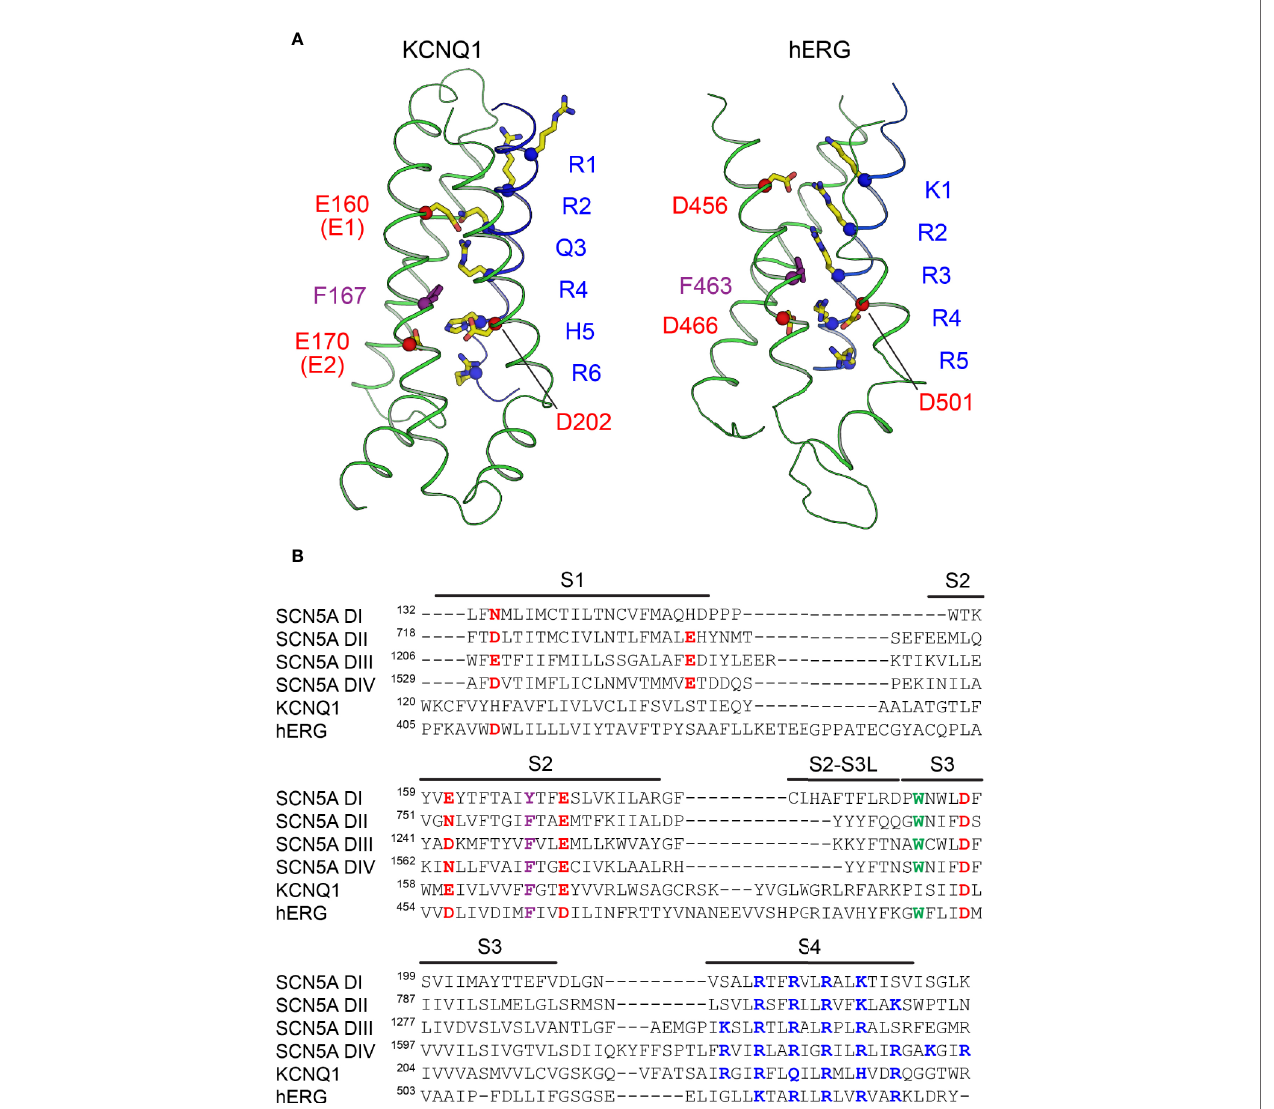
FIGURE 3 | The voltage sensors of KCNQ1, hERG, and SCN5A. (A) Structure of the VSD from human KCNQ1 (left) (PDB: 6UZZ) (Sun and Mackinnon, 2020) and hERG (right) (PDB: 5VA2) (Wang and Mackinnon, 2017) in putative activated conformations. Basic residues on S4 (labeled in blue), acidic residues on S2 and S3 (labeled in red), and the phenylalanine residue in the gating charge transfer center (purple) are shown as sticks. The fi rst four basic residues on S4 (R1 – R4) in KCNQ1 and the fi rst three (K1 – R3) in hERG are located above the charge transfer center. (B) Multiple sequence alignment of VSDs I-IV of SCN5A with the VSDs of human KCNQ1 and hERG. Basic residues in S4 implicated with voltage sensing are colored blue, and acidic or polar residues in S1 – S3 suggested to interact with S4 gating charges are colored red. The conserved aromatic residue at the gating charge transfer center in S2 is colored purple. Another tryptophan residue in S3, conserved in the VSDs of Na V channels and also present in hERG, is colored